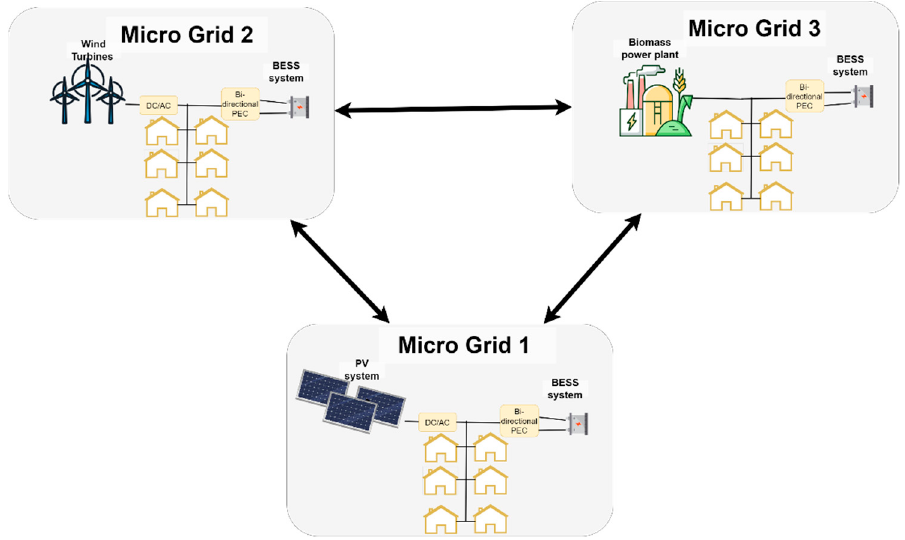
Figure 1. System setup of proposed IMMG system.